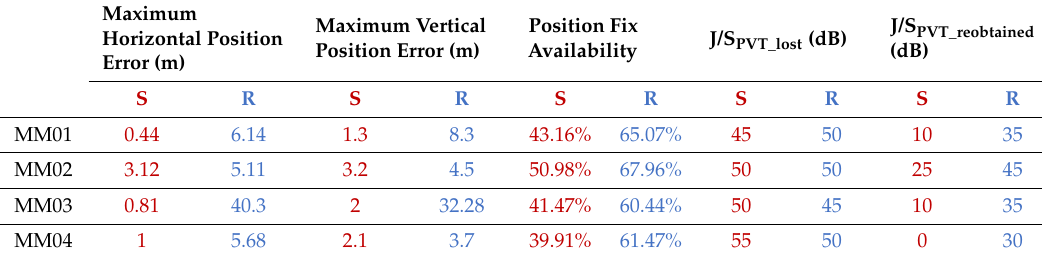
Table 7. Test results for MM RUT when with synthetic and recorded interference signals are